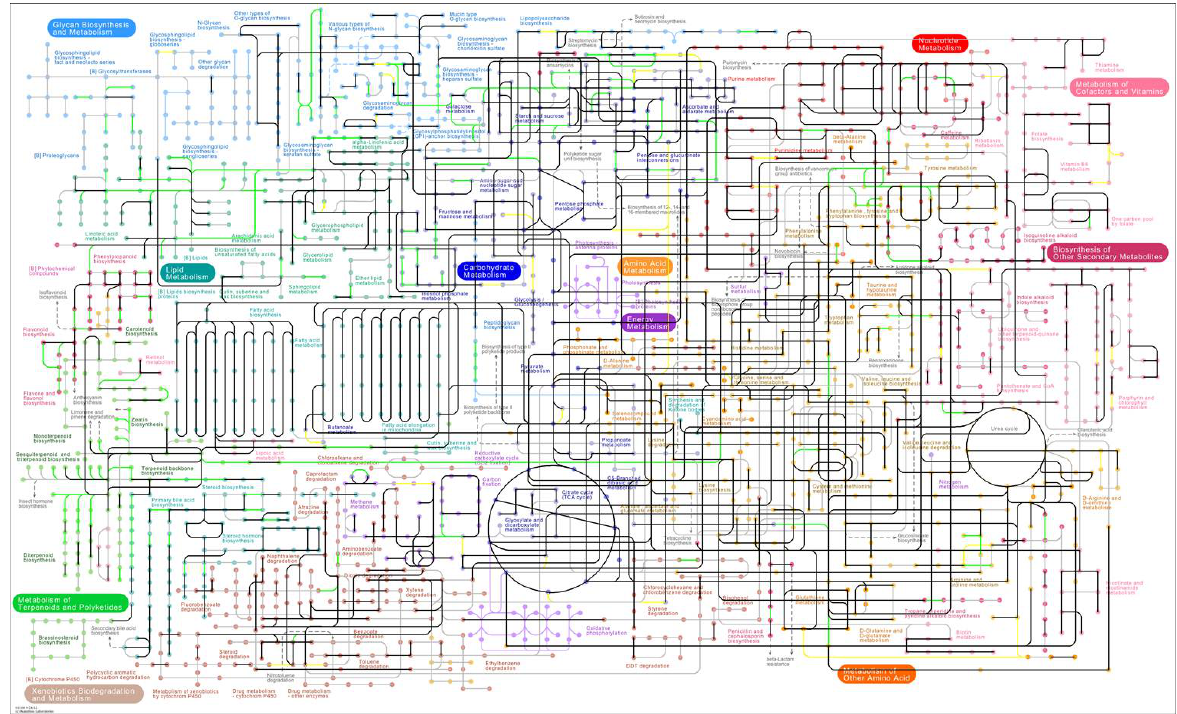
Figure 3. Interacting metabolic networks of Pseudomonas syringae pv. Tomato and Arabidopsis thaliana based on KEGG. Black edges represent common reactions between Pseudomonas syringae pv. Tomato and Arabidopsis thaliana , green edges represent Arabidopsis thaliana specific reactions, yellow edges represent Pseudomonas syringae pv. Tomato specific reactions, all other edges represent reactions not contained in either